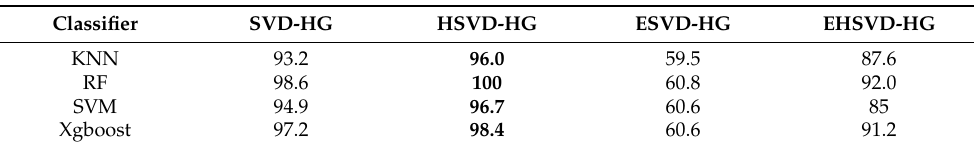
Table 7. Case Study-II: Classifiers Performance when Training and Testing with Different Oil Tem- peratures (training at 70 ◦ C and testing at 23 ◦